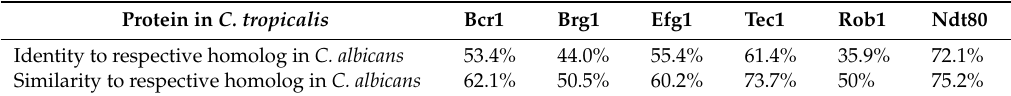
Table 2. Sequence alignment of C. tropicalis Bcr1, Brg1, Efg1, Tec1, Rob1, and Ndt80 with the respective homolog in C. albicans